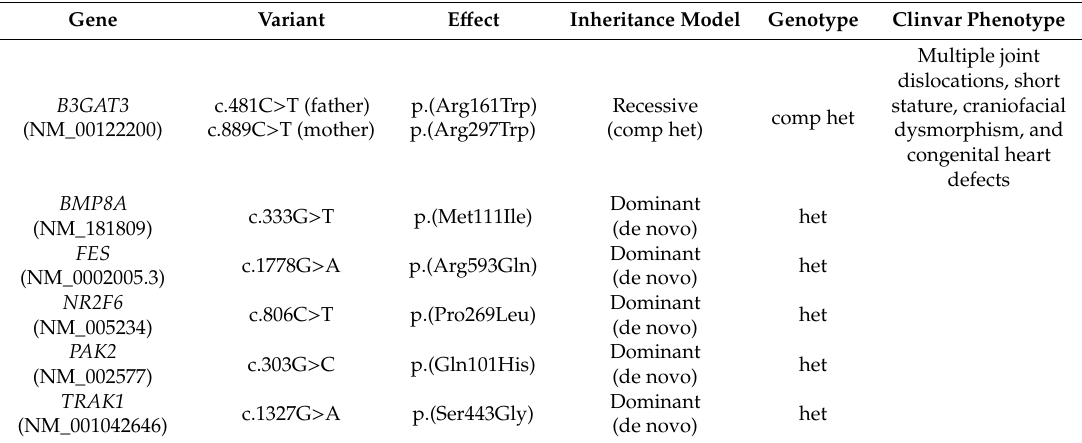
Table 1. Candidate genes after selecting